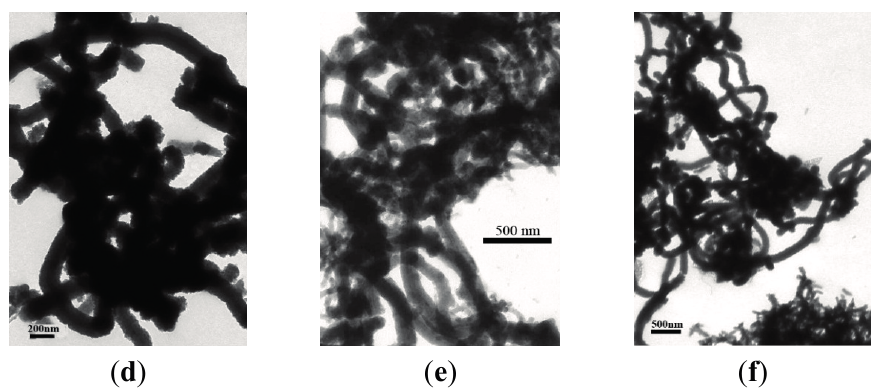
Figure 4. Transmission electron microscopy (TEM) images of ( a ) C-CNTs; ( b ) Pure PANI; and ( f )